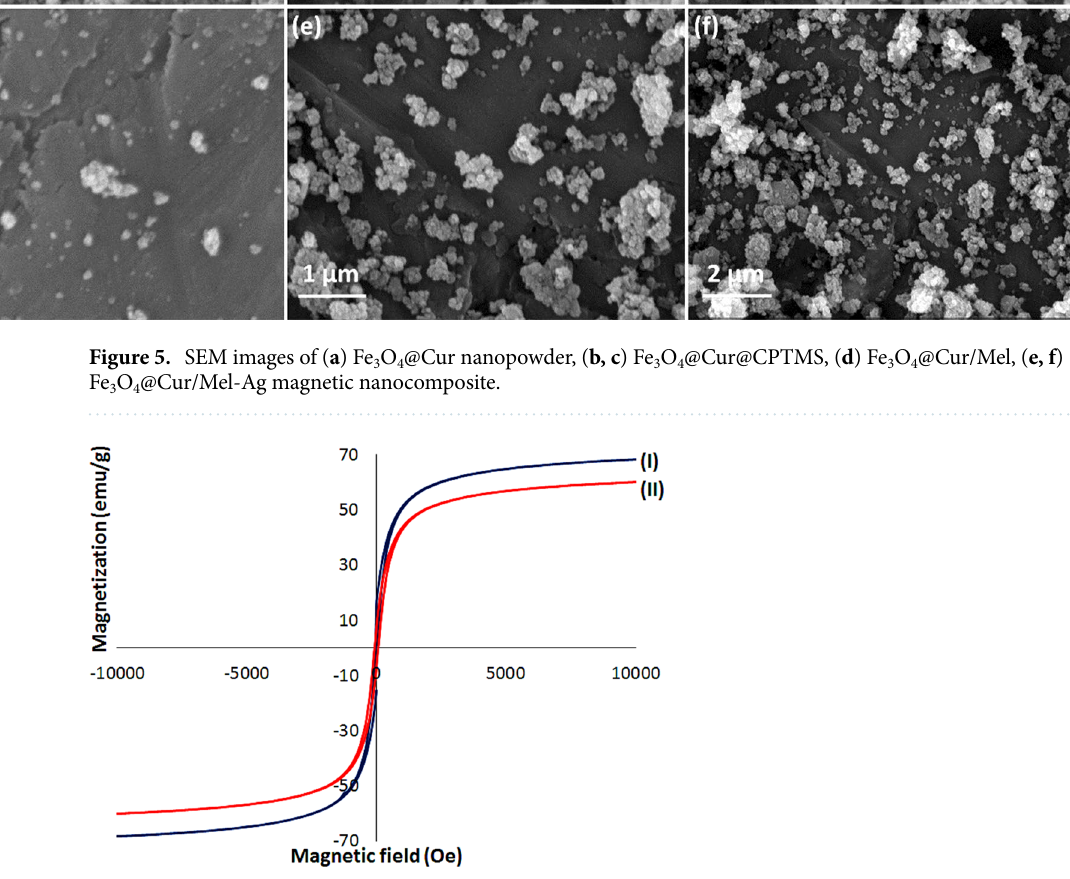
Figure 6. ( a ) The room temperature M–H curves of ( I ) Fe 3 O 4 @Cur nanopowder and ( II ) Fe 3 O 4 @Cur/Mel-Ag magnetic